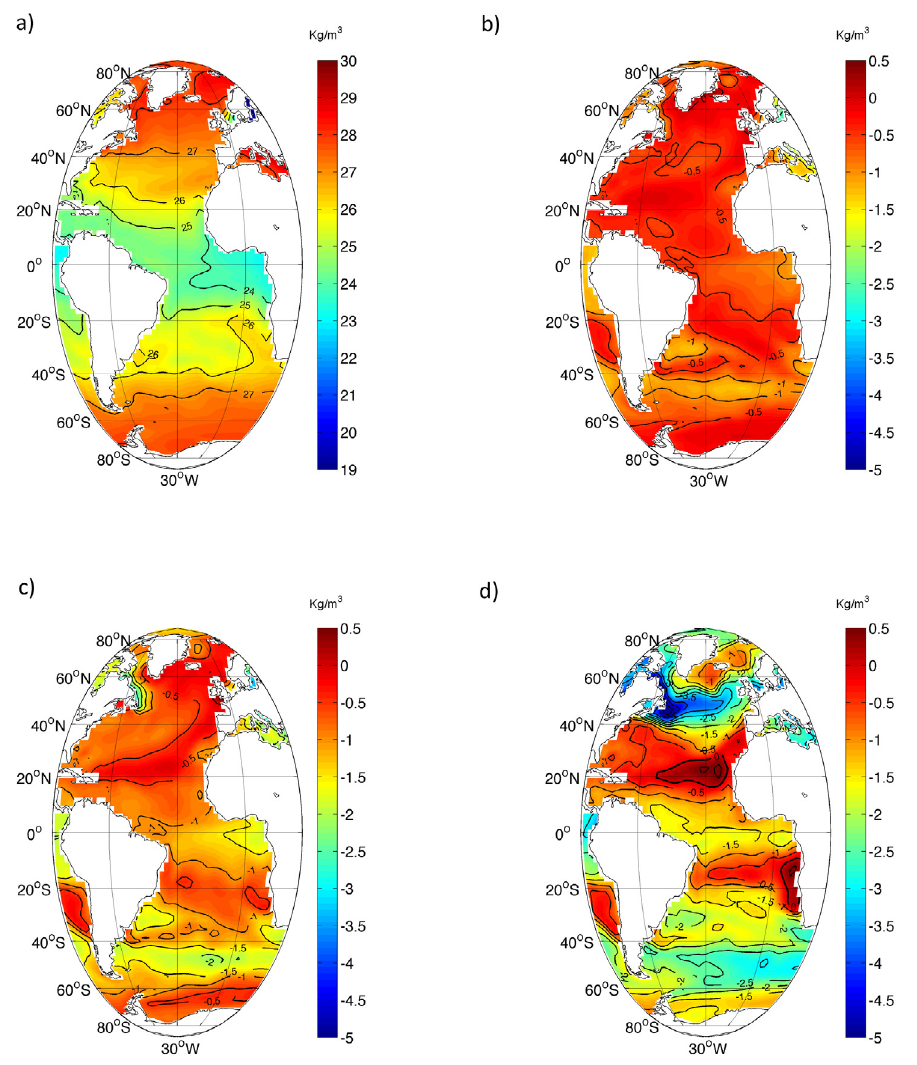
, (c) 8CO and (d) 16CO and 2 2 2